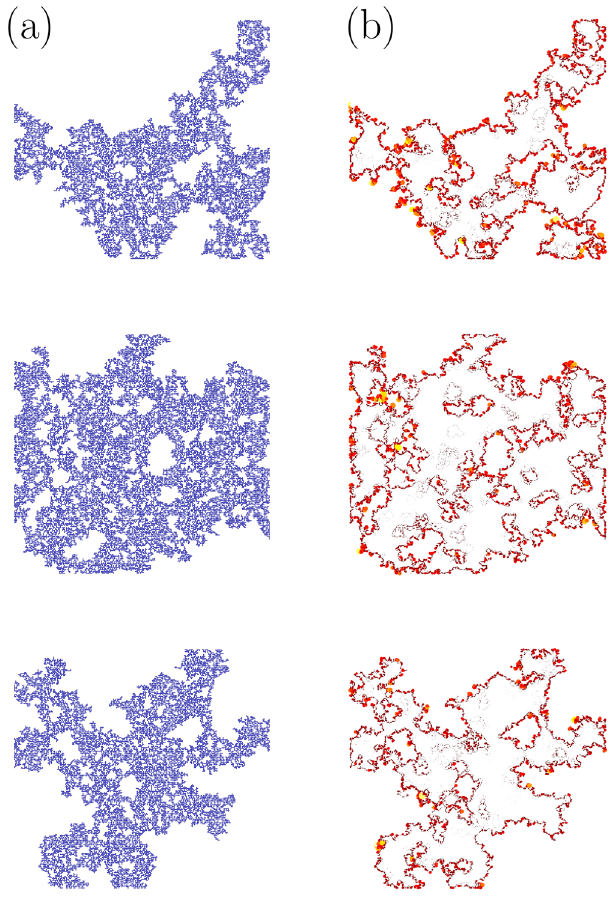
Fig. 1 Critical percolating networks are archetypal examples of random fractals. a Here we see three fi nite snapshots of critical clusters with linear size L = 250 and b the local density of states of the studied topological lattice model at the centre of the mobility gap E = 0. Despite the seeming absence of clear distinction between the bulk and edge modes, these structures support robust quantized